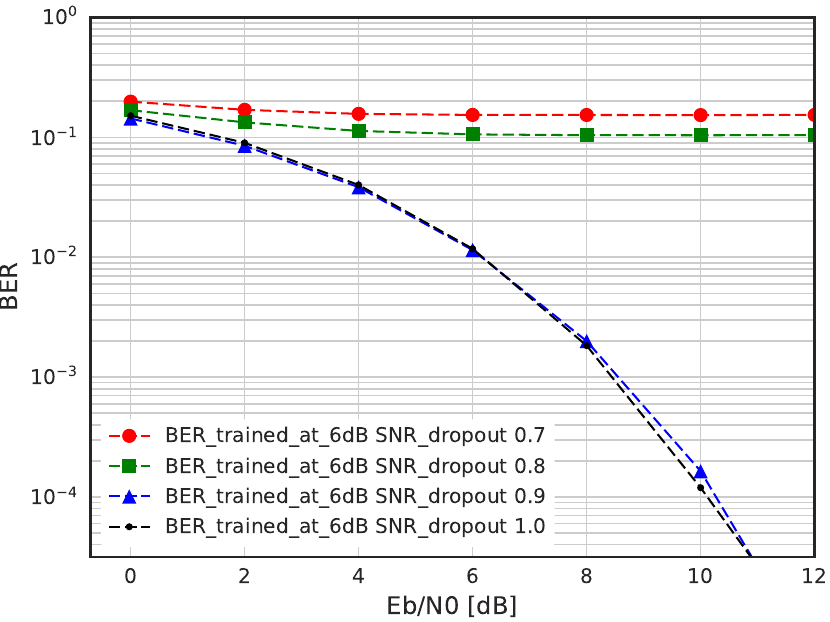
Figure 13. BER performance of DSM with dropout.